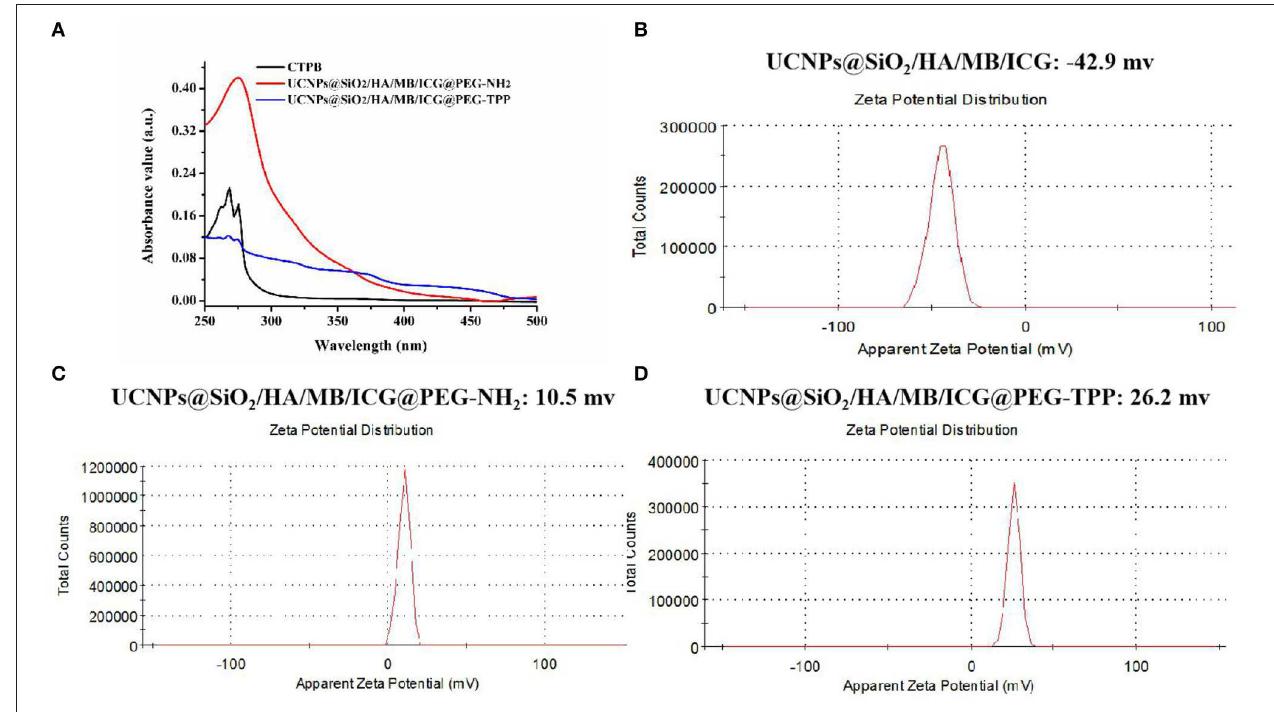
FIGURE 2 | (A) Uv-Vis spectra of CTPB, UCNPs@SiO 2 /HA/MB/ICG@PEG-NH 2 , UCNPs@SiO 2 /HA/MB/ICG@PEG-TPP; Zeta-potential of (B) UCNPs@SiO 2 /HA/MB/ICG; (C) UCNPs@SiO 2 /HA/MB/ICG@PEG-NH 2 ; (D) UCNPs@SiO 2 /HA/MB/ICG@PEG-TPP.